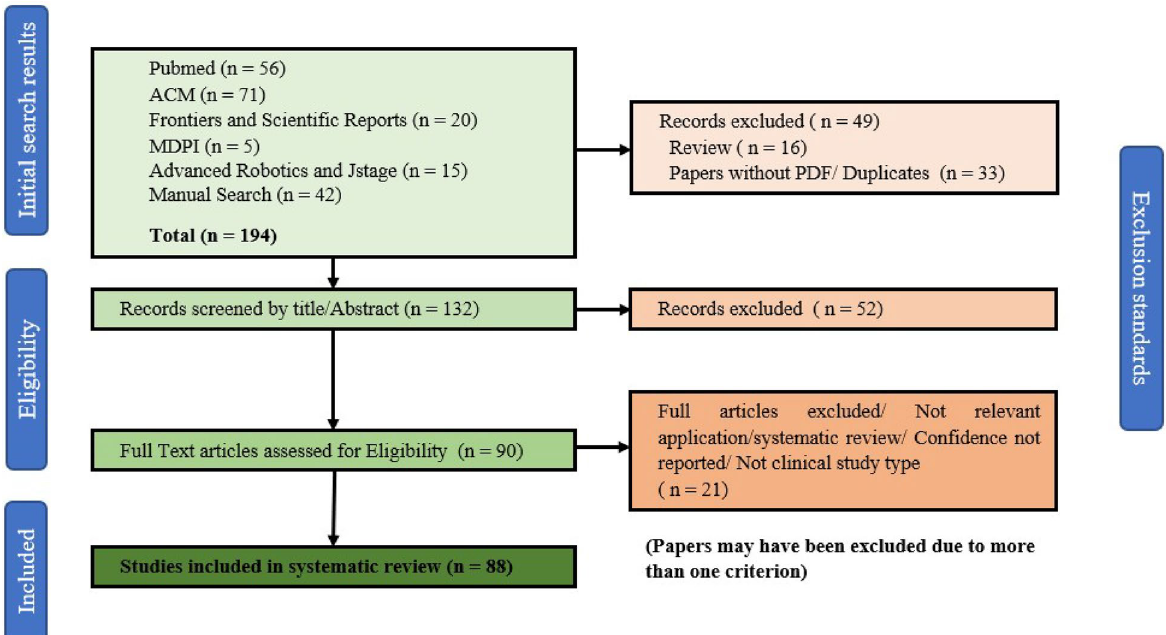
Fig. 2 Preferred Reporting Items for Systematic Reviews and Meta‑Analyses (PRISMA) flow diagram. The PRISMA chart details the search and selection strategy employed during the work